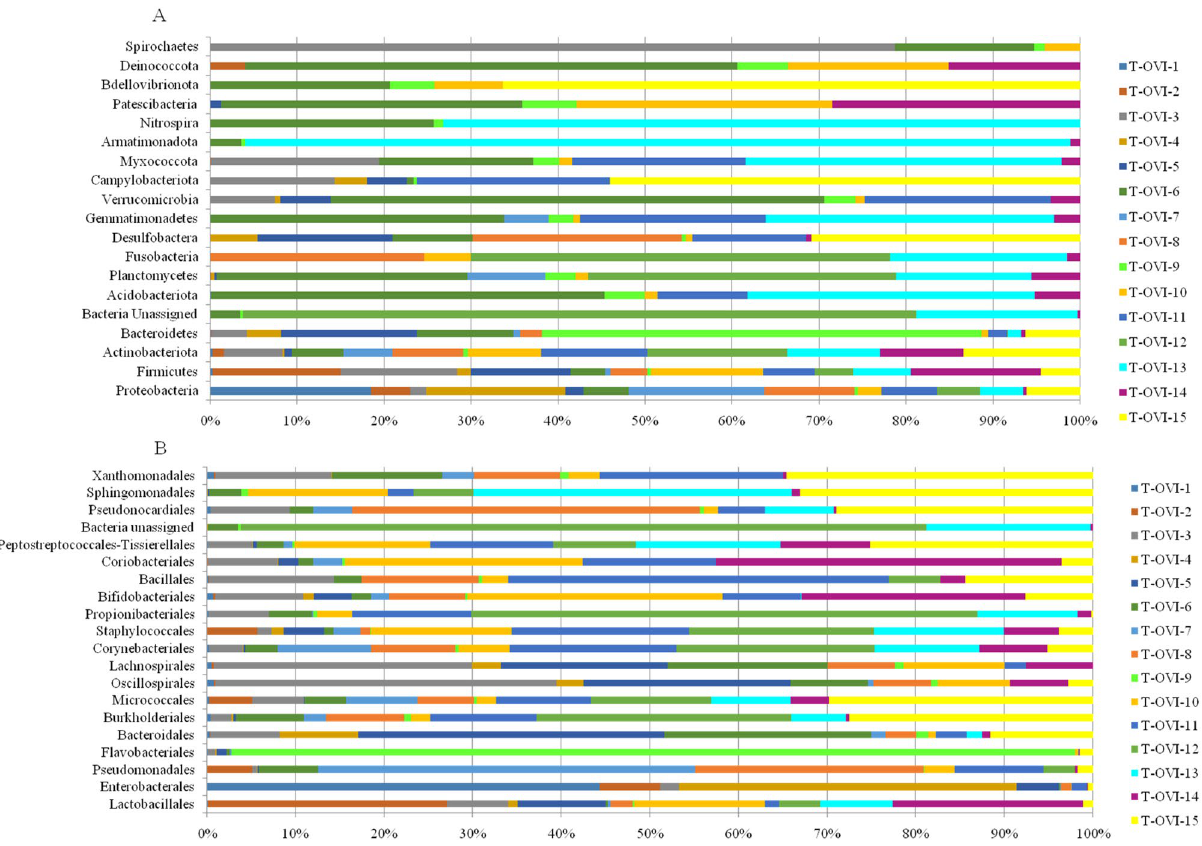
Figure 1. ( A ) Relative abundance of ASV´s classified at phylum level in each sample; ( B ) Relative abundance of 20 most common ASV at the order level in each